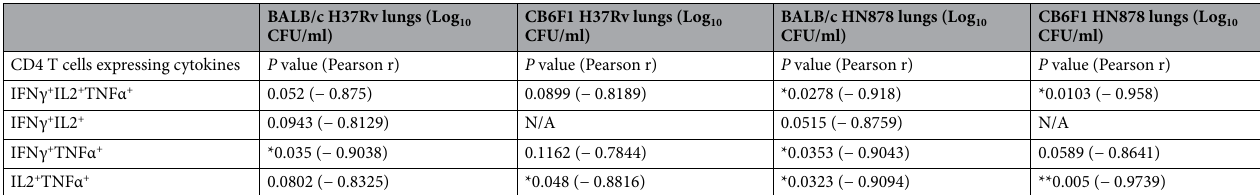
Table 2. Correlation of BALB/c lungs (Log 10 CFU/ml) and CB6F1 lungs (Log 10 CFU/ml) mice vaccinated and challenged with H37Rv or HN878 versus multifunctional CD4 T cells of M7 stimulated splenocytes from mice vaccinated with BCG. Correlation analysis. Correlation analysis between the TB burden in the lungs (Log 10 CFU/ml) of BALB/c and CB6F1 mice infected with H37Rv or HN878 versus correlation analysis between the multifunctional CD4 T cells. Correlation coefficient was assessed using Pearson’s two-tailed correlation test with ρ value (*ρ < 0.05, **ρ < 0.005).